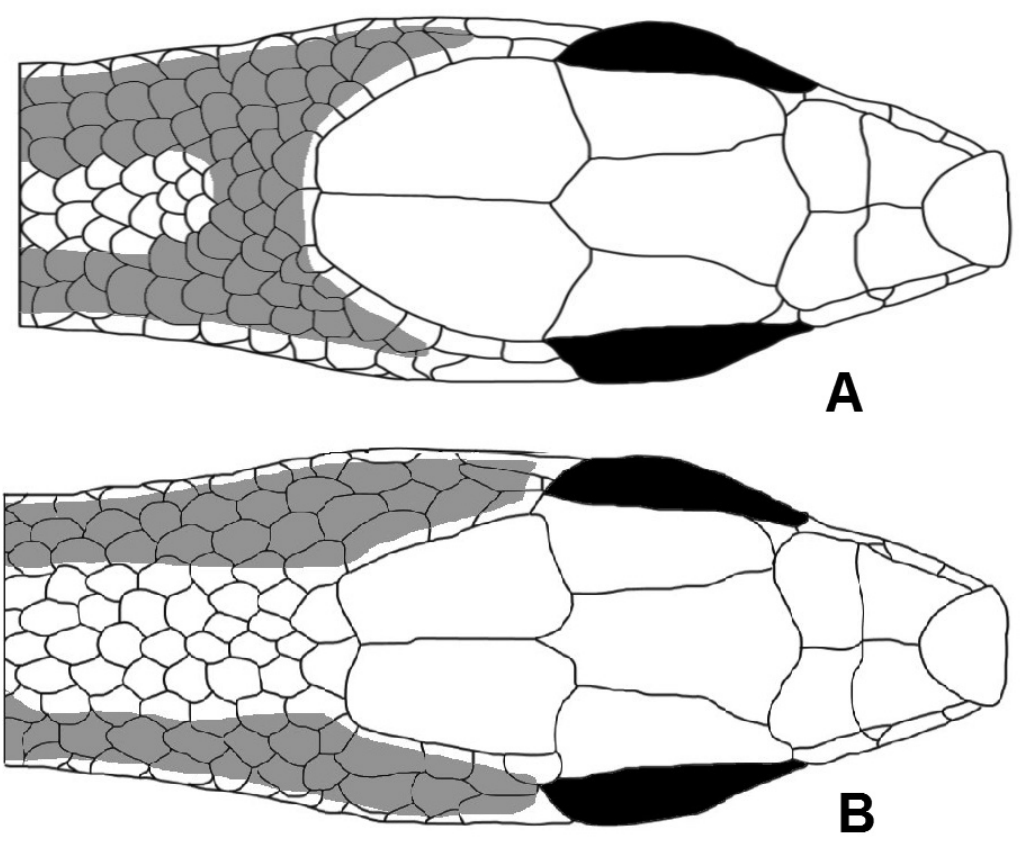
Fig. 16. A . Vertebral line normally separated from the parietal region. B . Vertebral line reaching the parietal region.